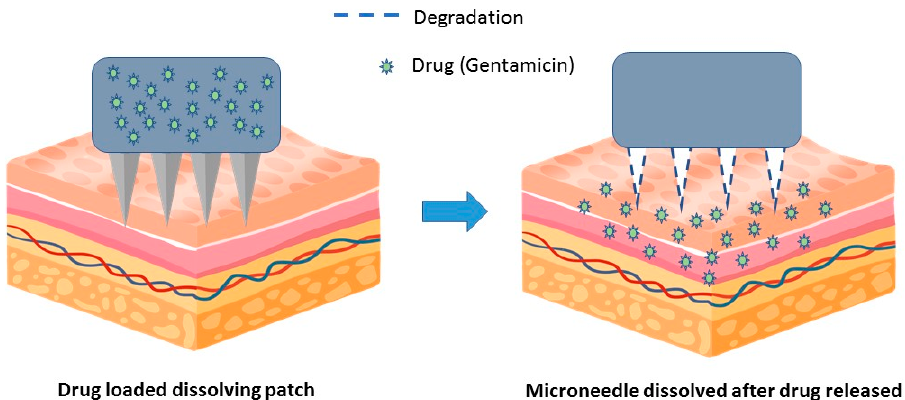
Figure 5. The microneedles in these patches are made out of biodegradable materials. After gentamicin has been released from the patch, the microneedle dissolve on the skin.